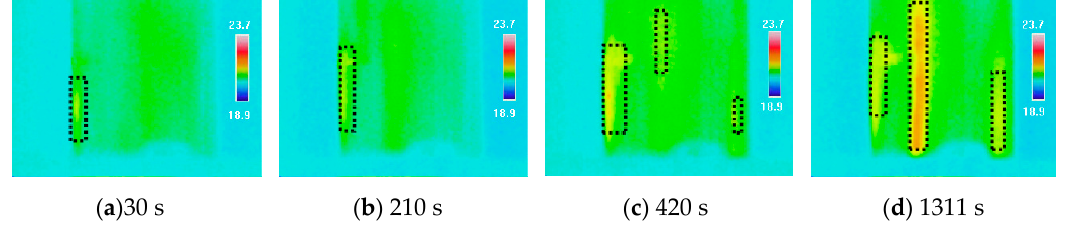
Figure 7. Thermal images of specimen A4 at different moments.